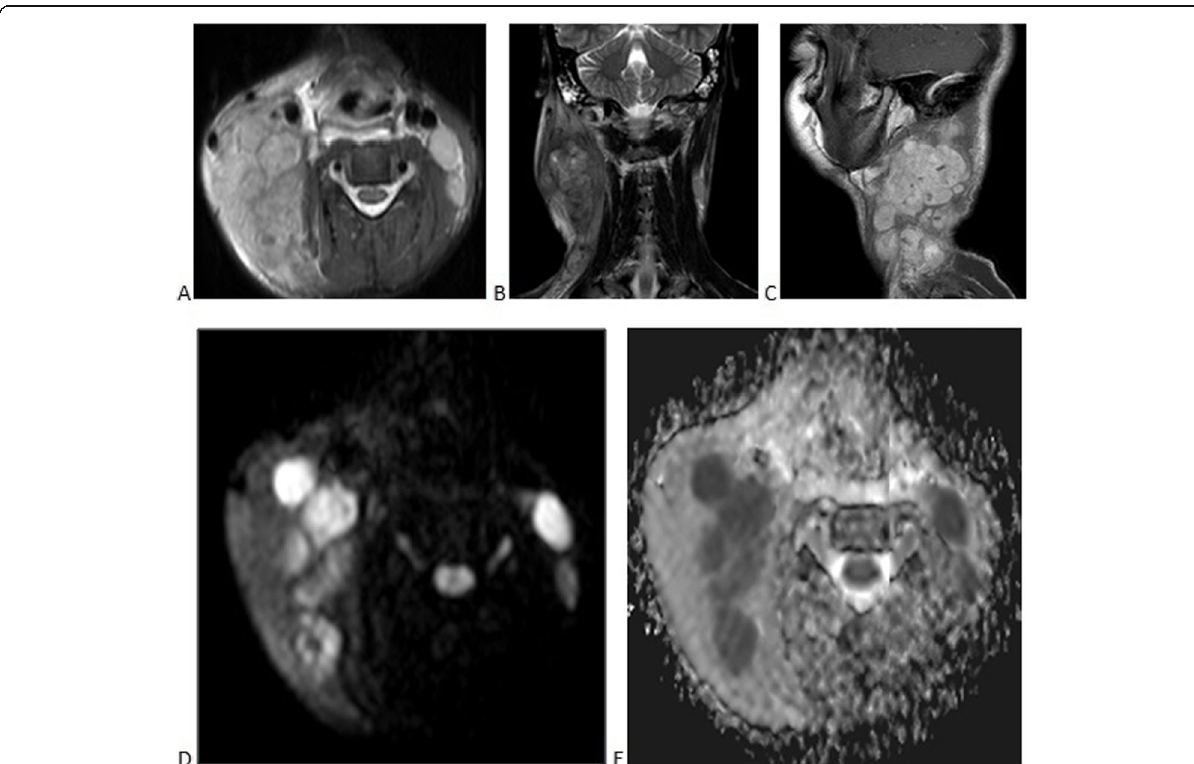
Fig. 9 Thirty-three- year-old patient presenting with bilaterally enlarged deep cervical lymph nodes much more extensive on the right a axial T2 WIs and b coronal T2 WIs showing intermediate signal of the enlarged lymph nodes. c Post-contrast sagittal T1 WIs showing fair homogenous contrast uptake in the post-contrast sequences . d DWIs b 1000 and e ADC map showing partially hyperintense LNs in diffusion images corresponding to low signal in ADC map, with an ADC value of 1.3 × 10 − 3 mm 2 /s. The biopsy was negative for metastatic nodal deposits,